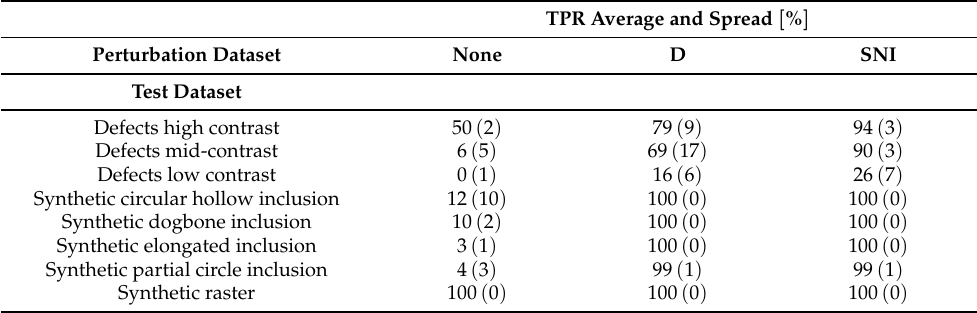
Table 3. Results for the unsupervised–trained autoencoder model, OOD detector. The TPR is given as the average and the spread ( max − min ) /2 ) within parenthesis, at 0.1% FPR. Results are shown for training with weld okay and different perturbation datasets, where D denotes the real defect dataset and SNI is the synthetic natural image indications